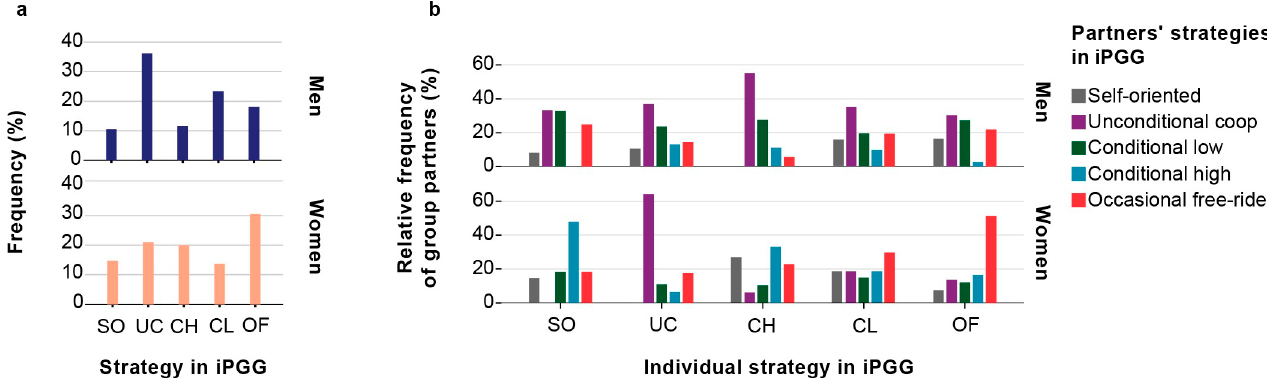
Fig 3. The frequency distribution of strategies in the iterated Public Goods Game among (a) all men and all women and (b) among the partners of men and women that employed a specific strategy. Strategies in the iPGG: Self-oriented (SO): always invested < 50% of own funds into common pool; Unconditional Cooperator (UC): always invested � 75% of own funds, even if in previous rounds cooperation failed; Conditional, Starting High (CH): started with high investments and further declined (at least in one of subsequent interactions); Conditional, Starting Low (CL): entered interactions with low investments, but increased over the course of the game (at least in one of subsequent interactions); Occasional Free-rider (OF): invested 0 or suddenly crucially reduced investments amid high investments of other participants in the group.